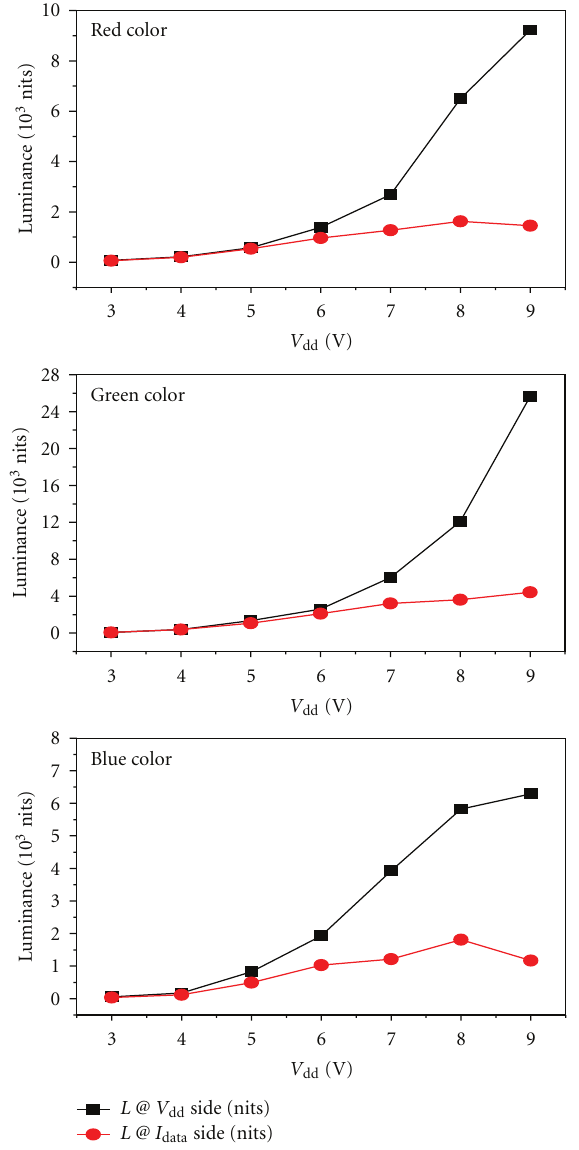
Figure 5: Measurement results for OLED luminance degradation for each RGB element in conventional 2-TFT pixel circuit.